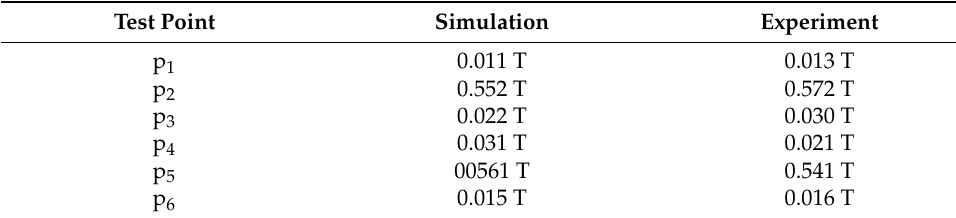
Table 1. The simulation value compared with experimental results.